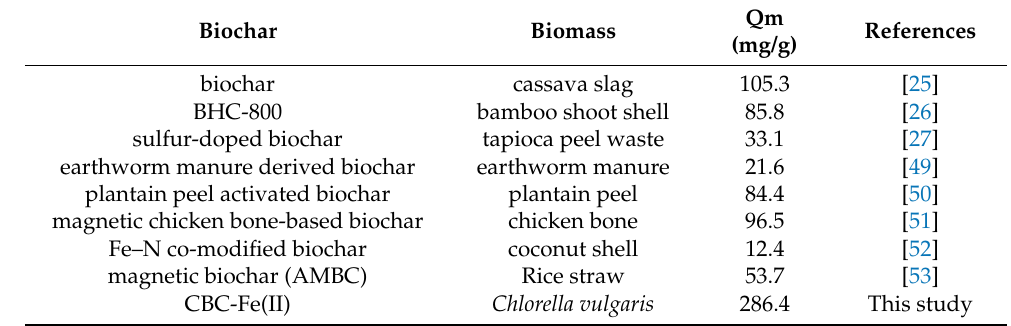
Table 5. Comparison of the adsorption capacity of RhB with other biochar adsorbents reported in the literature.